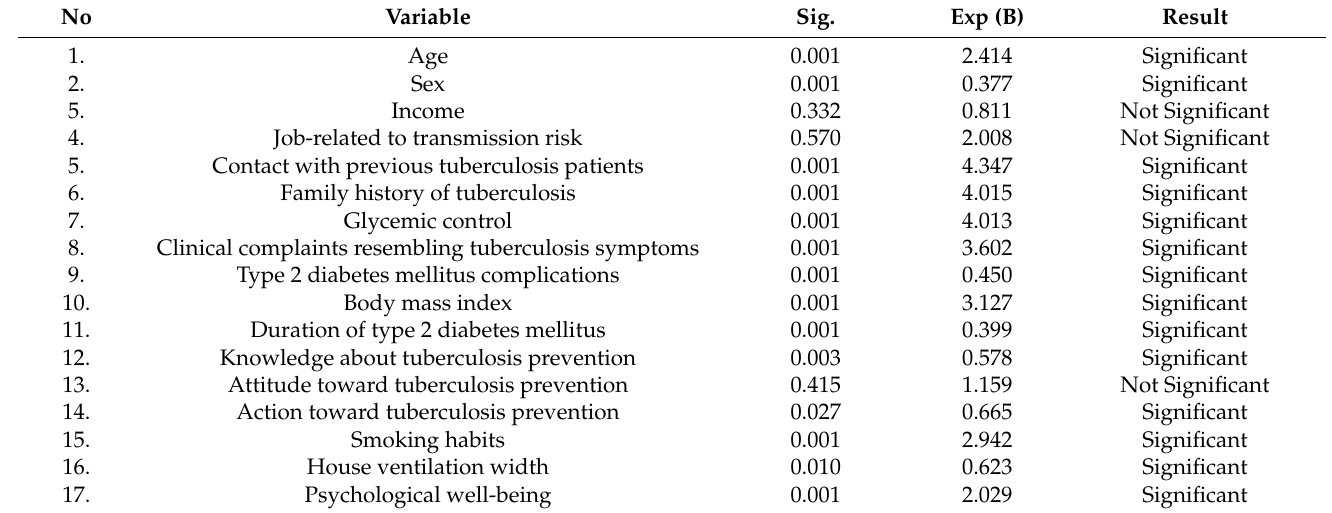
Table 1. Simple logistic regression test results before tuberculosis predictive index for type 2 diabetes mellitus compilation.